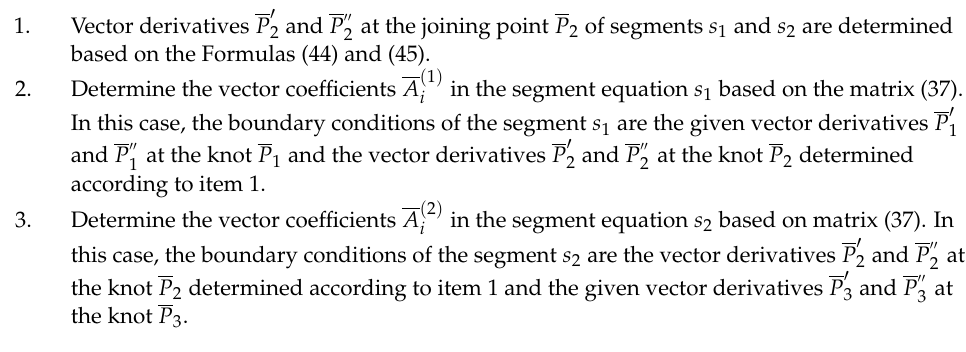
Algorithm 3 For obtaining a fifth-degree B é zier spline curve of segments s 1 and s 2 has